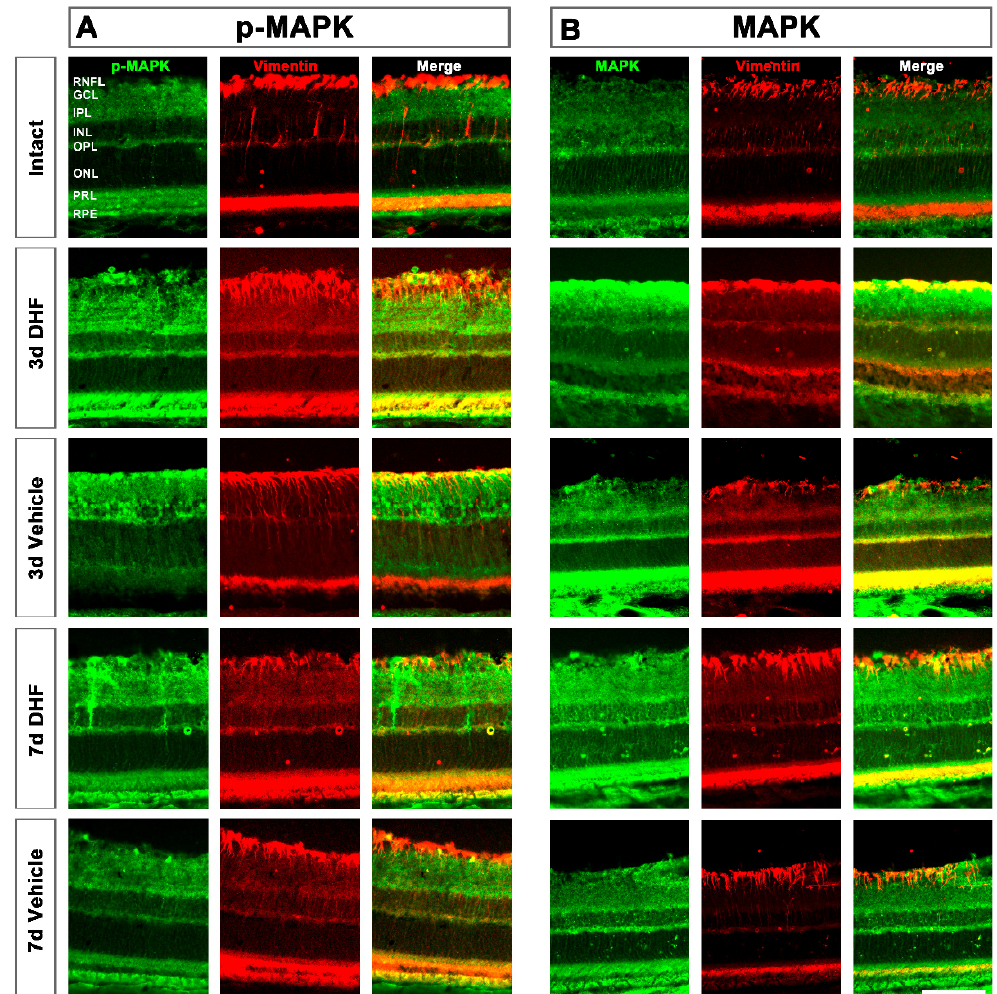
Figure 2. Activation of MAPK signaling pathway in Müller cells (MCs). Representative micrographs (20×) of phosphorylated (p-) MAPK ( A ) and total MAPK ( B ) signal in intact, and axotomized retinas treated with DHF or vehicle at 3 and 7 days after IONT. The signal of each protein, MCs immunodetected with vimentin and the co-localization of both images are shown. RNFL = retinal nerve fiber layer, GCL = ganglion cell layer, IPL = inner plexiform layer, INL = inner nuclear layer, OPL = outer plexiform layer, ONL = outer nuclear layer, PRL = photoreceptor layer, RPE = retinal pigment epithelium. Scale bar at the bottom right = 50 µm.